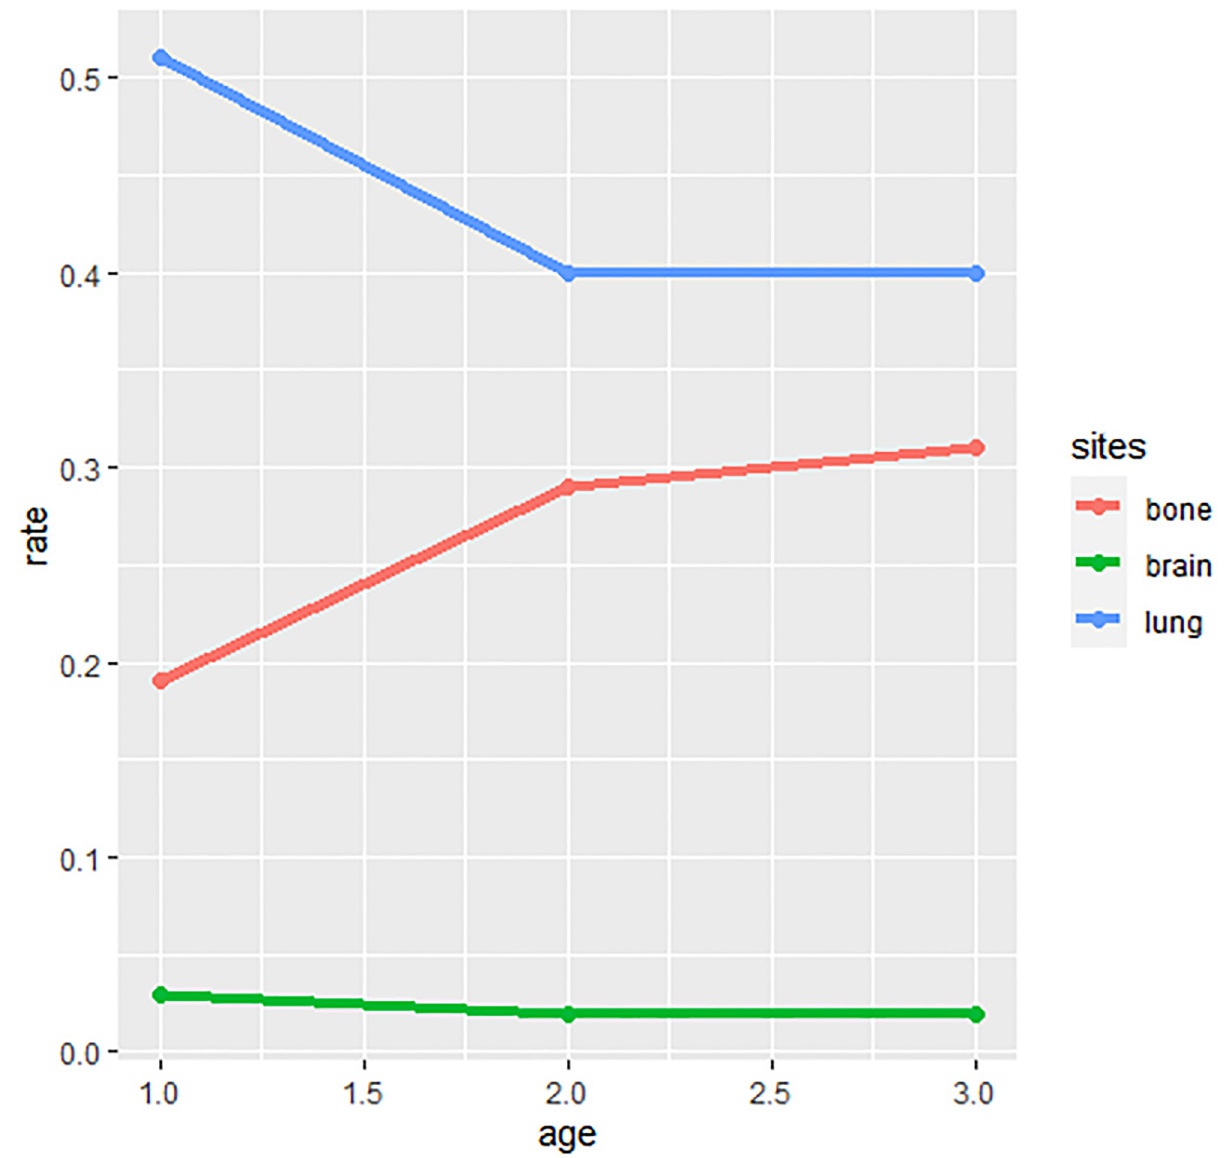
Fig 1. Rate of distant metastatic sites associated with age. The line chart shows the metastasis rate of bone, brain and lung at three age groups ( < 50 years, 50–59 years and � 60 years). Y-axis represent metastasis rate and X-axis represent age groups.